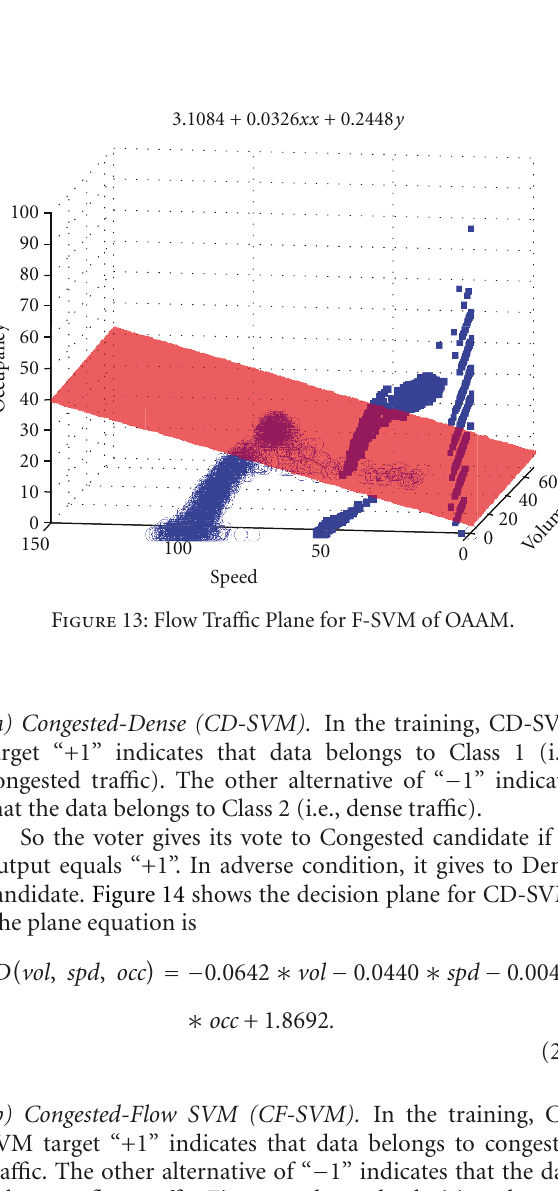
(c) Flow-Dense SVM (FD-SVM). In the training, FD-SVM target “+1” indicates that data belongs to flow tra ffi c.